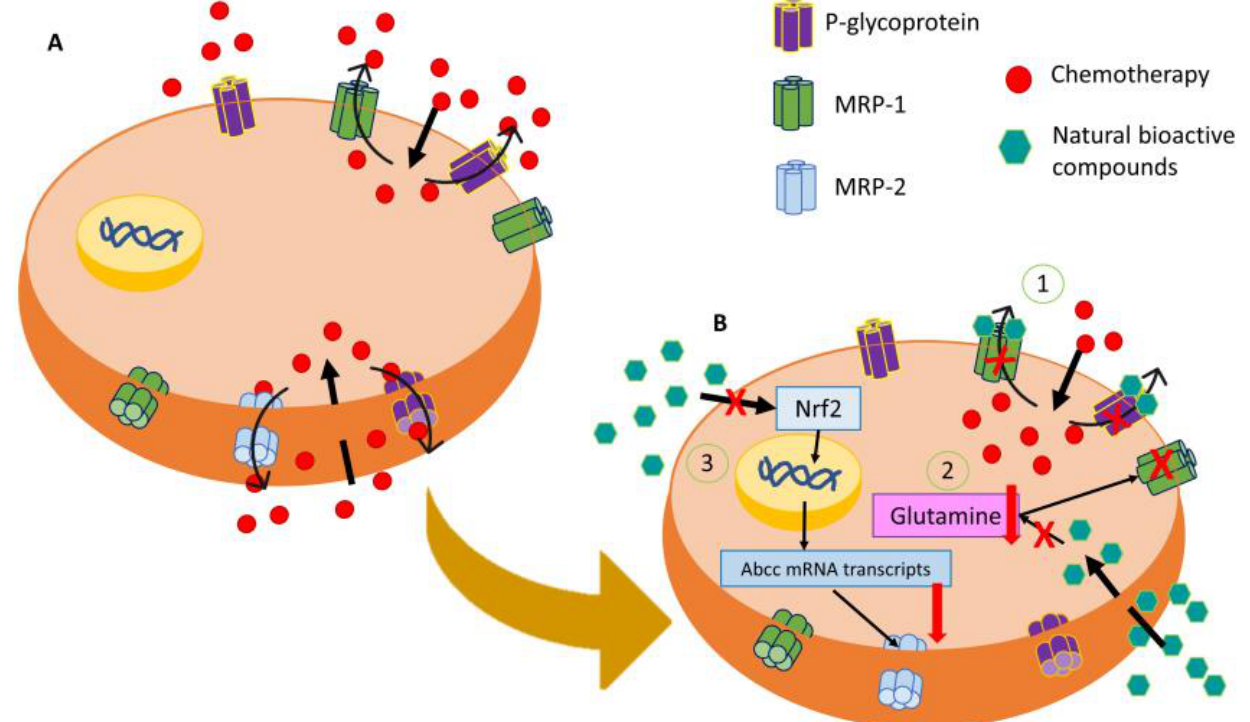
Figure 1. Representative image of modulation of the MDR mechanism of resistance by natural bio- active compounds. ( A ) Main membrane transporters that are involved in chemoresistance by expel- ling them into the extracellular medium. ( B ) Action of natural bioactive compounds in the regula- tion of MDR by (1) MRP-2 downregulation through the inhibition of the Nrf2/MRP2 pathway, (2) P-glycoprotein and MRP-1 blocking by natural bioactive compounds, and (3) inhibition of gluta- mine cell intake producing an MRP-1 disfunction.